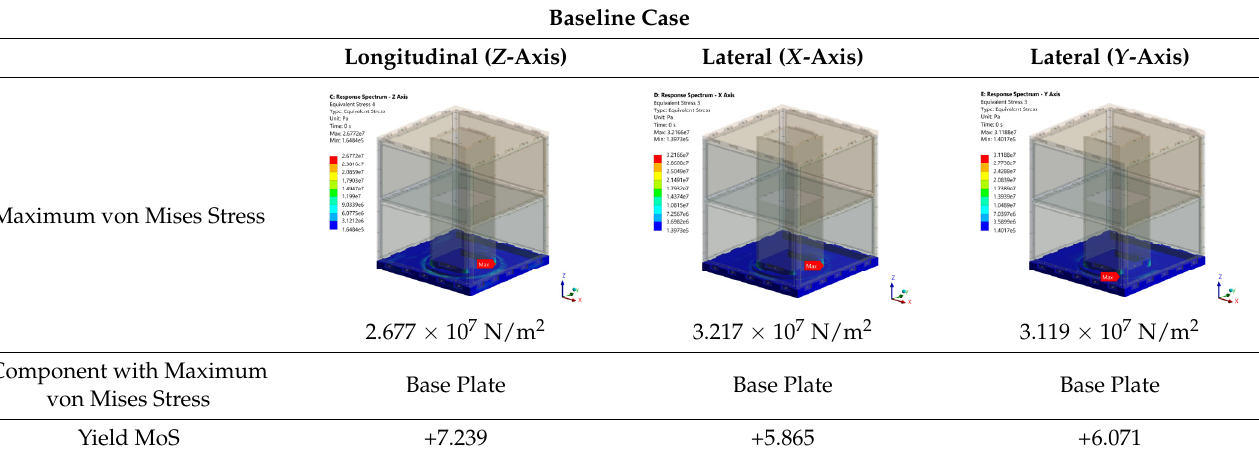
Table 8. Baseline and perforated shock launch loads—maximum von Mises stresses.